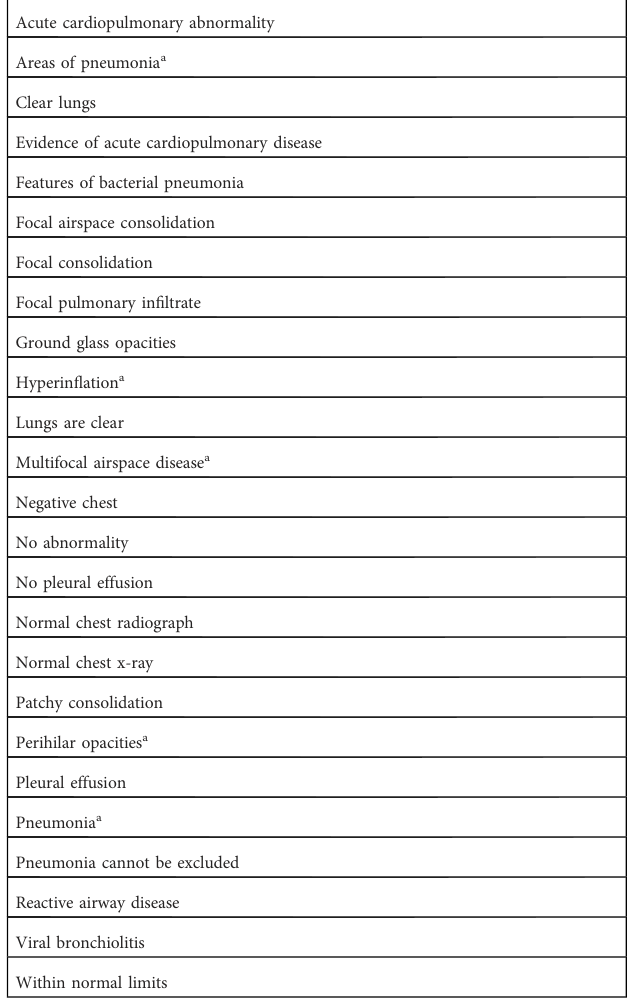
TABLE 1 Keywords used to train natural language processing